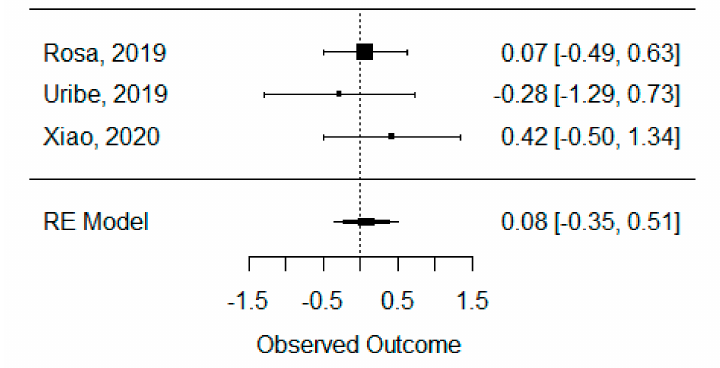
Figure 2. Forest plot for the standardized mean difference obtained for bone formation volume analysis synthetic measures reported in the included systematic reviews.